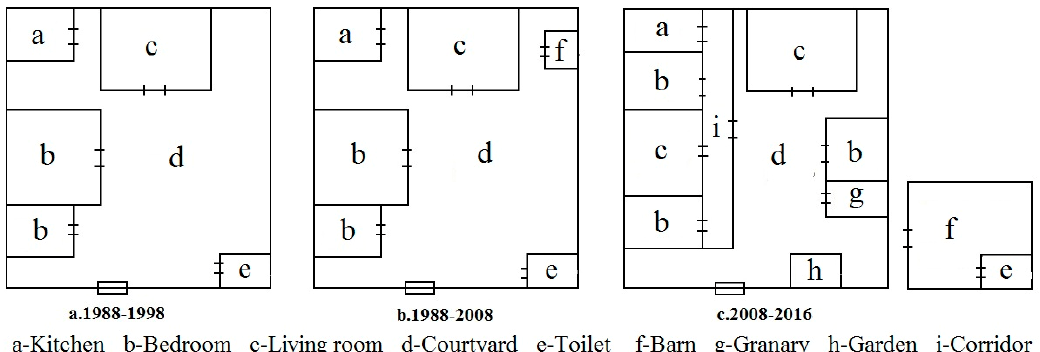
Figure 6. Changes in rural settlement land use structure in Sihe village.